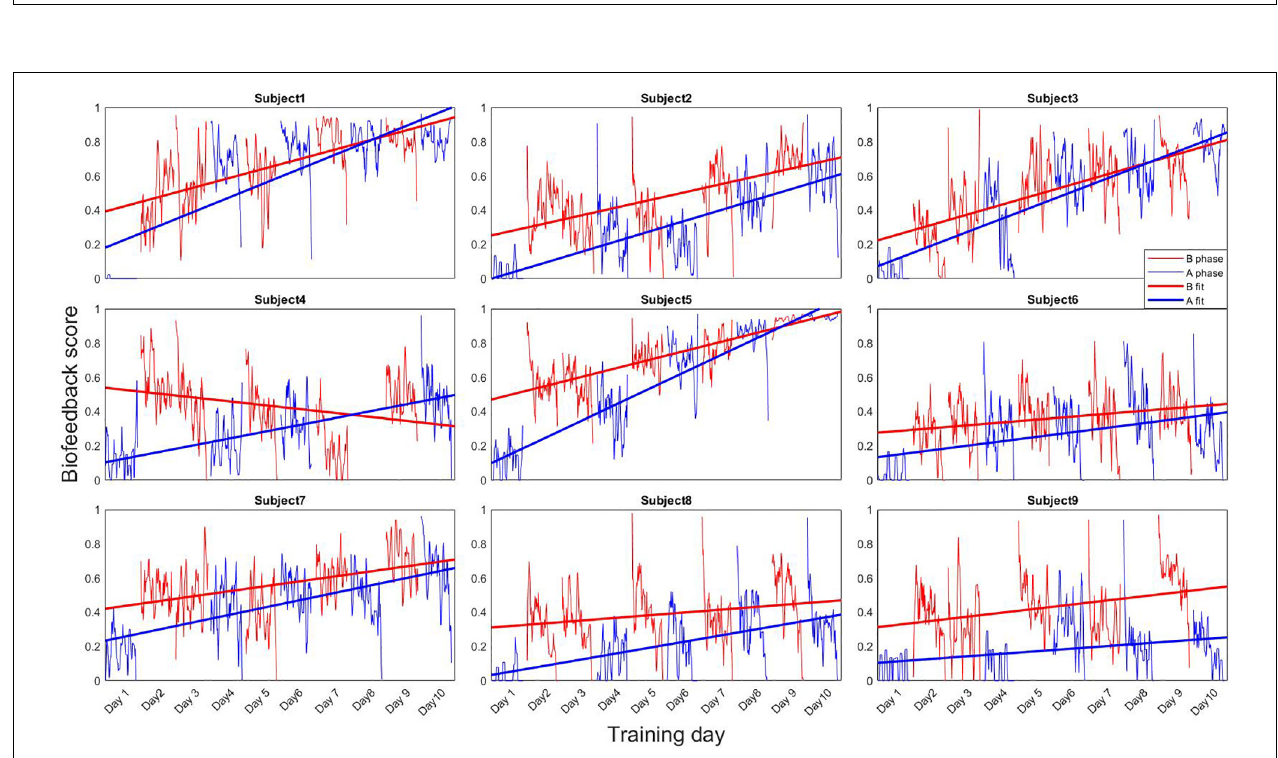
FIGURE 4 | Evolution of the breathing biofeedback score and the HRV indexes. Changes across the whole training in panel (A) the average biofeedback score; (B) the high frequency component of HRV (0.15–0.4 Hz); (C) the coherence between the low frequency HRV and breathing; (D) the low frequency component of HRV (0.04–0.15 Hz). BFB ON, B phases, where online biofeedback was presented; Stderr, Standard Error; LF-breathing coherence, coherence between the low frequency component of HRV and breathing; LF HRF, low frequency HRV.